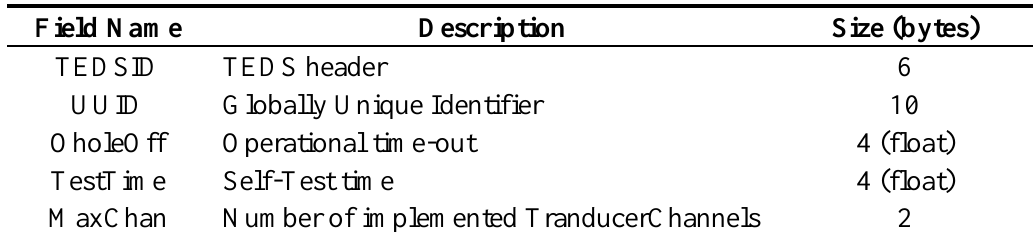
Table 2. Partial listing of